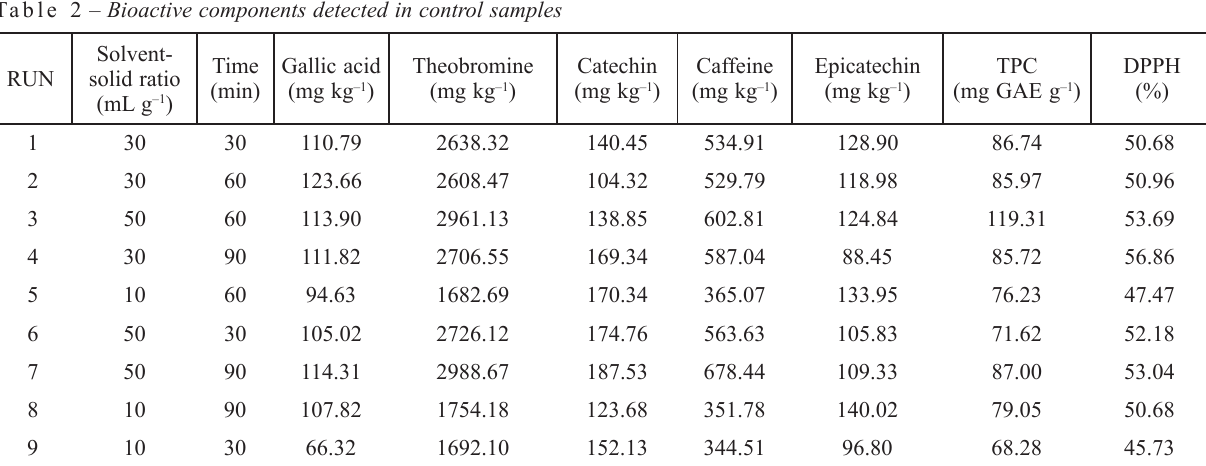
Table 2 – Bioactive components detected in control samples Solvent- RUN solid ratio